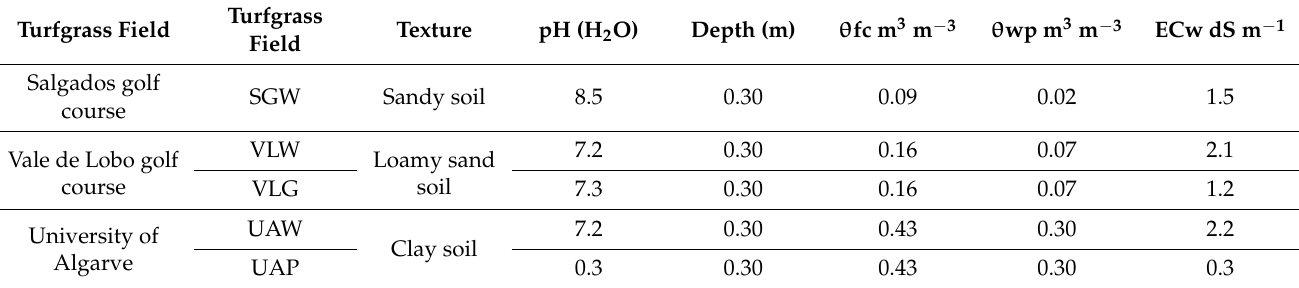
Table 2. Soil properties of the turfgrass fields.